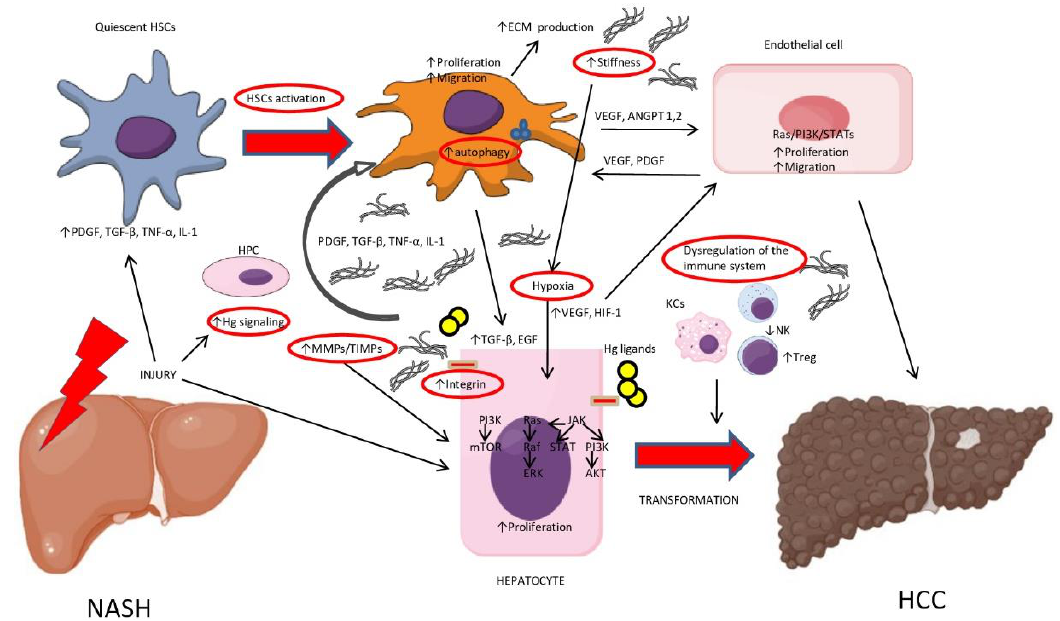
Figure 1. Fibrosis-dependent mechanisms of hepatocarcinogenesis in non-alcoholic steatohepatitis (NASH). Abbreviations: Hh, Hedgehog; PDGF, platelet derived growth factor; TGF- β , transforming